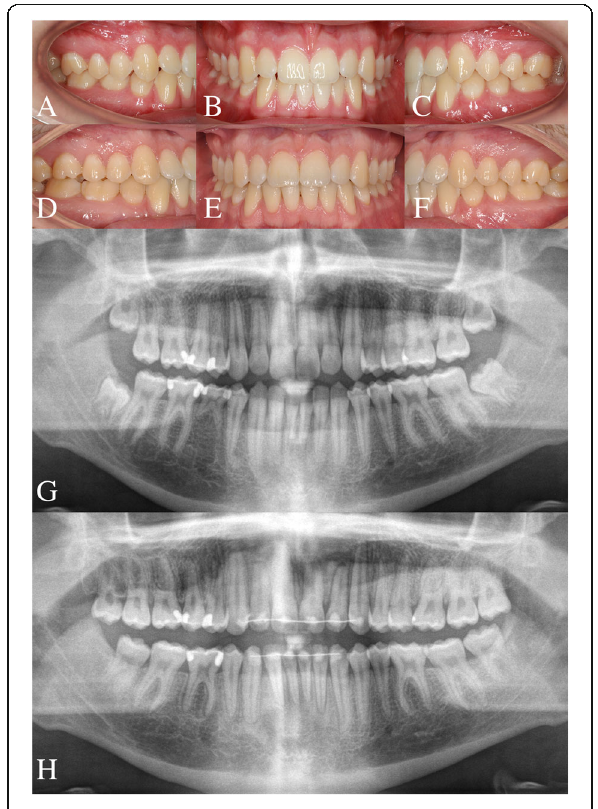
Fig. 1 A typical case of unilateral space closure. a – c , Pretreatment photographs. d – f Post-treatment photographs. g , h Pre- and post-